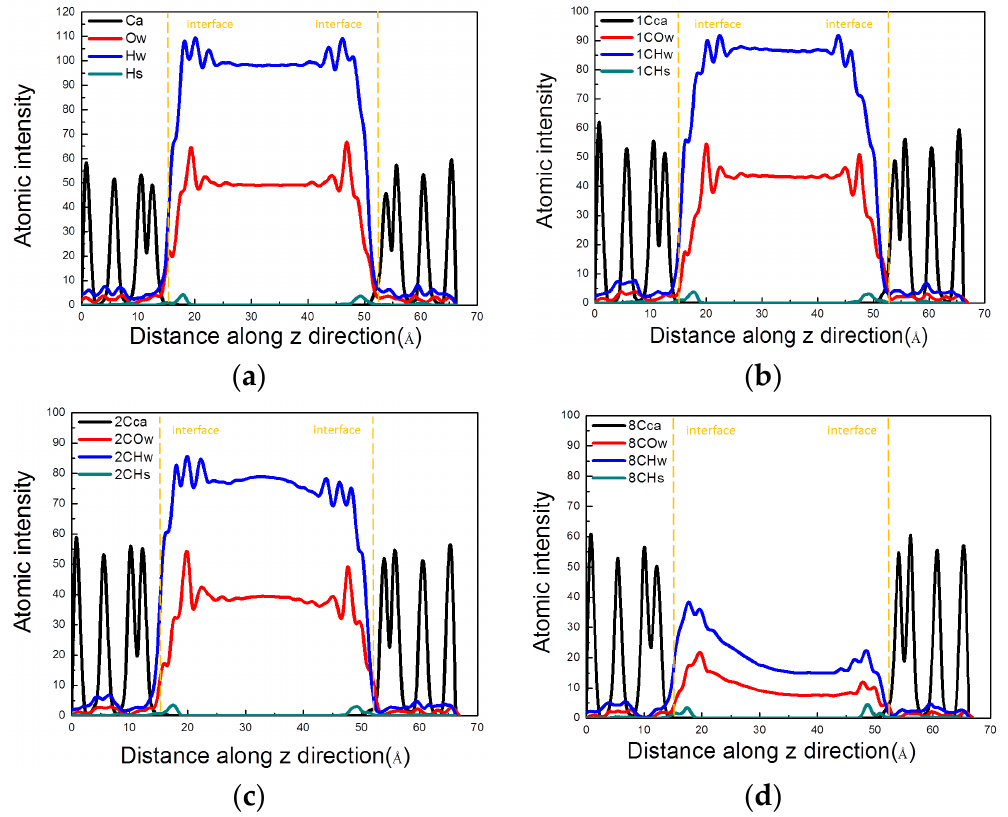
Figure 12. Intensity distribution of atoms along the Z -direction at 2500 ps. ( a ) Blank; ( b ) MTES; ( c ) VTEO; ( d ) octyltriethoxysilane. (Ow and Hw: oxygen and hydrogen in water molecules, respectively; Hs: hydrogen in surface hydroxyls of calcium silicate hydrate (C–S–H); 1C represents MTES; 2C represents VTEO; 8C represents octyltriethoxysilane).